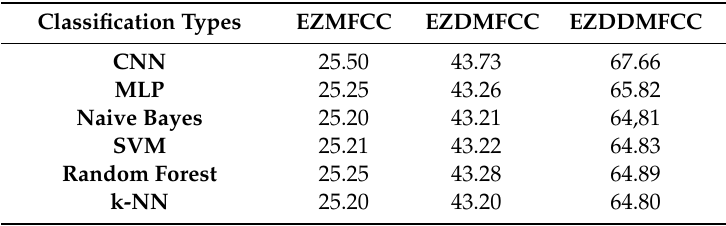
Table 10. Computational times (in seconds) for male speakers based on a 20-ms Hamming window with GRU. CNN: Convolutional neural network; MLP: Multilayer perceptron; SVM: Support vector machine; k-NN: k nearest neighbor; EZMFCC: energy, zero crossing rate (ZCR), and MFCC; EZDMFCC: energy, ZCR, and delta-MFCC; EZDDMFCC: energy, ZCR, and